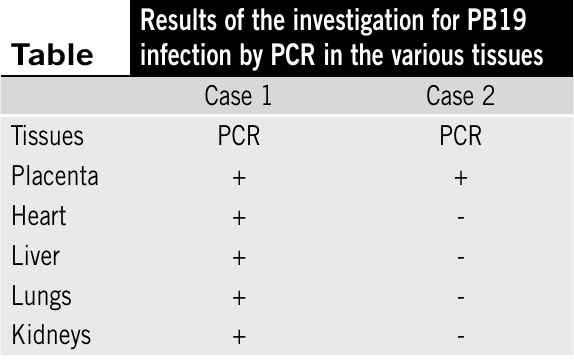
PCR: polymerase chain reaction.